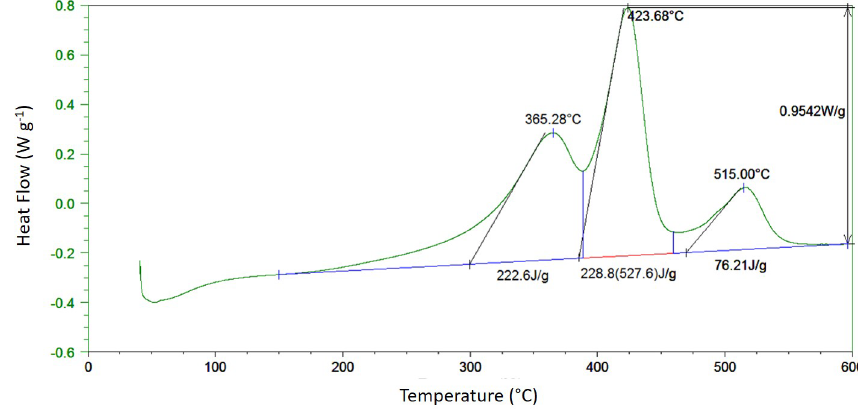
Figure 1. Measurement of characteristics from differential scanning calorimetry thermograms (green line). After identification of peak maxima, peak height (Wg − 1 ) was measured as the maximum deviation from a linear baseline drawn between 150 and 600 ◦ C, as illustrated for the main peak of the thermogram (0.9542Wg − 1 ). Total heat release (527.6Jg − 1 ) corresponds to the surface of the graph delimited by the linear baseline. Peak area (J g − 1 ) was obtained by identifying the minimum between two adjacent peaks and splitting the peaks perpendicularly to the baseline. The black lines indicate the maximum rate of reaction associated with each maximum, and they cross the baseline at the onset point (the temperature at which oxidation of the material